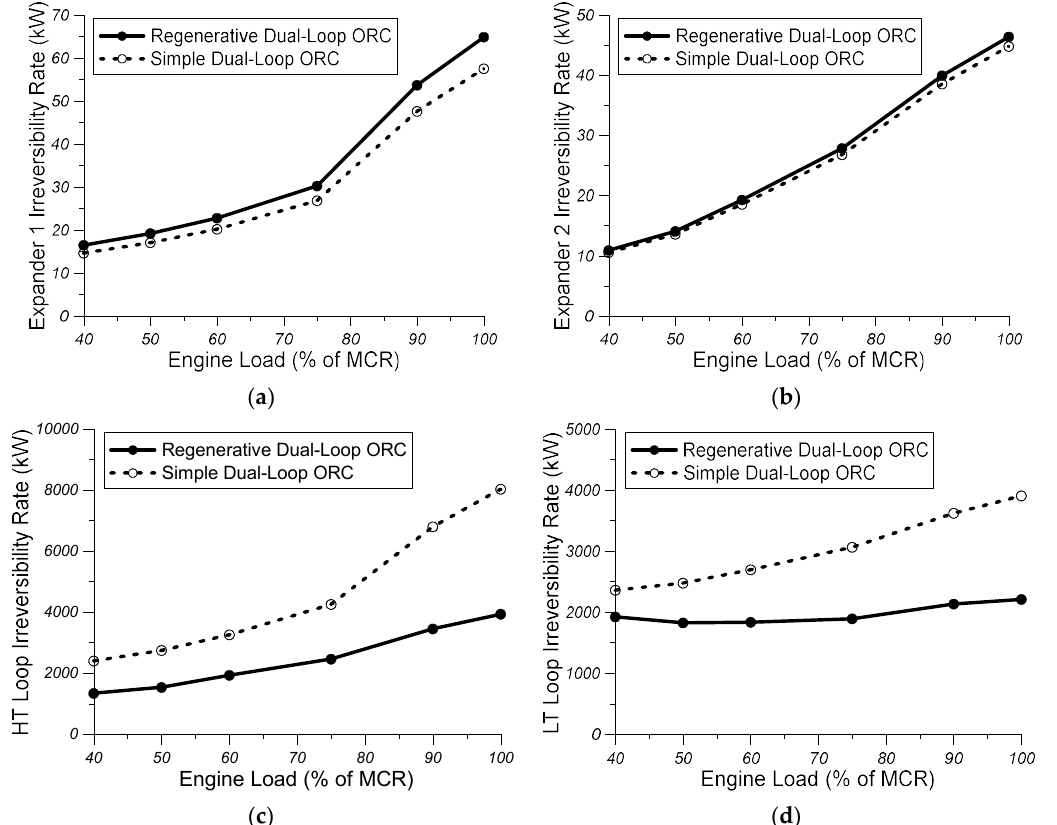
Figure 21. Comparison of ( a ) irreversibility rate in the expander of the HT loop, ( b ) irreversibility rate in the expander of the LT loop, ( c ) total irreversibility rate of the HT loop, and ( d ) total irreversibility rate of the LT loop between the simple dual-loop ORC and the regenerative dual-loop ORC.